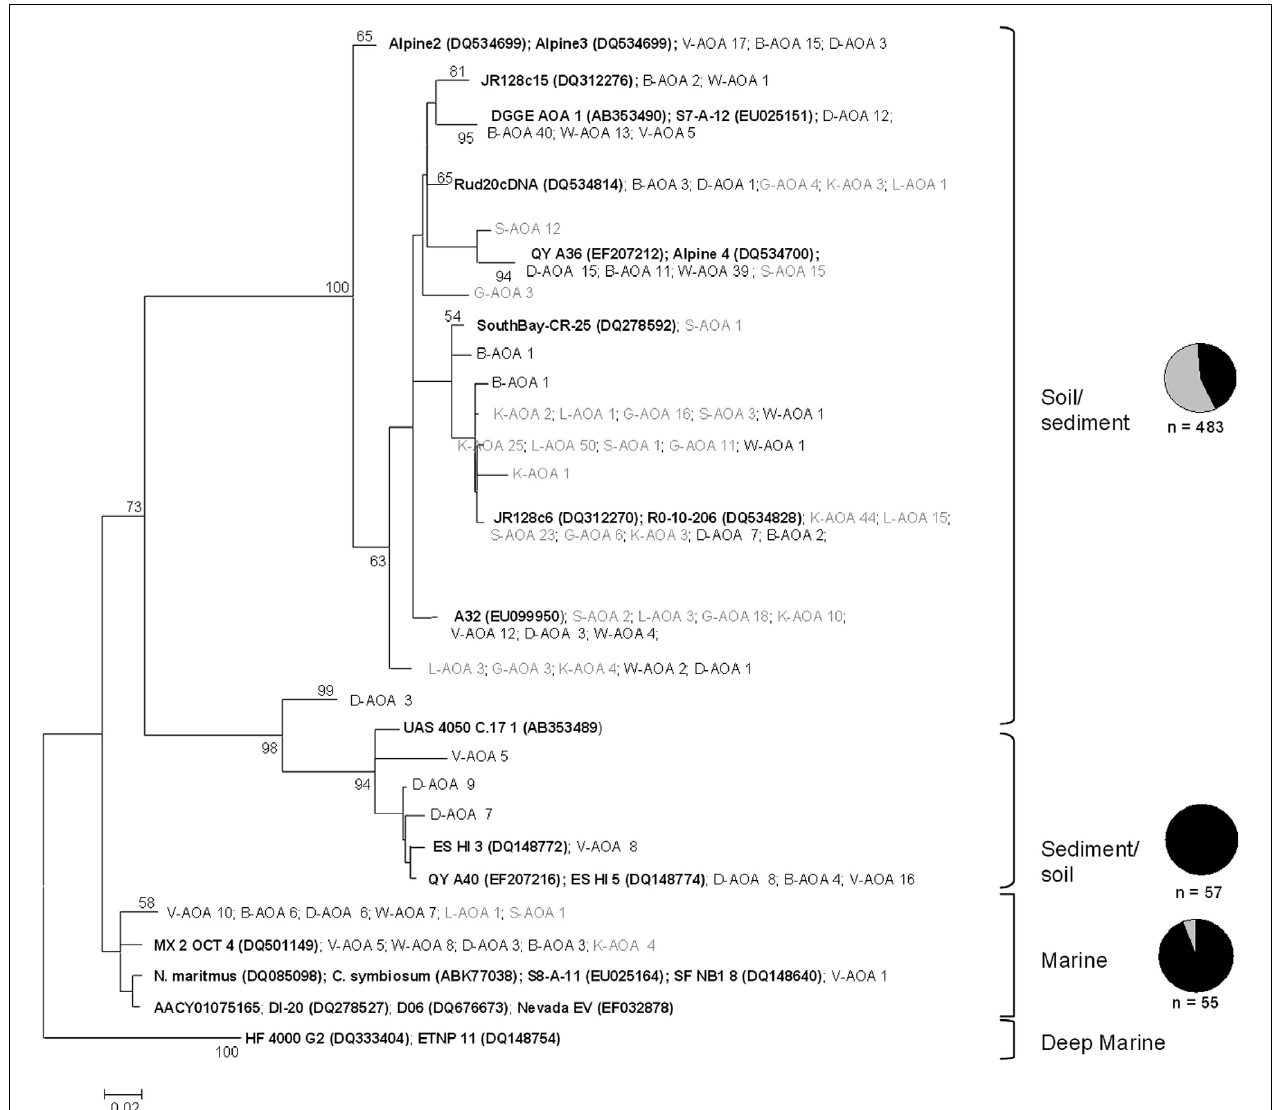
( > 50) represent values from Neighbor-joining, using JTT substitution model (1000 replicates and 8 gamma rates; expressed as percentage). First letters represent the soil of origin followed by the number of clones found in that specific soil. Reference sequences are in bold described as “Name (accession number).”The tree was rooted with two sequences within the deep marine water